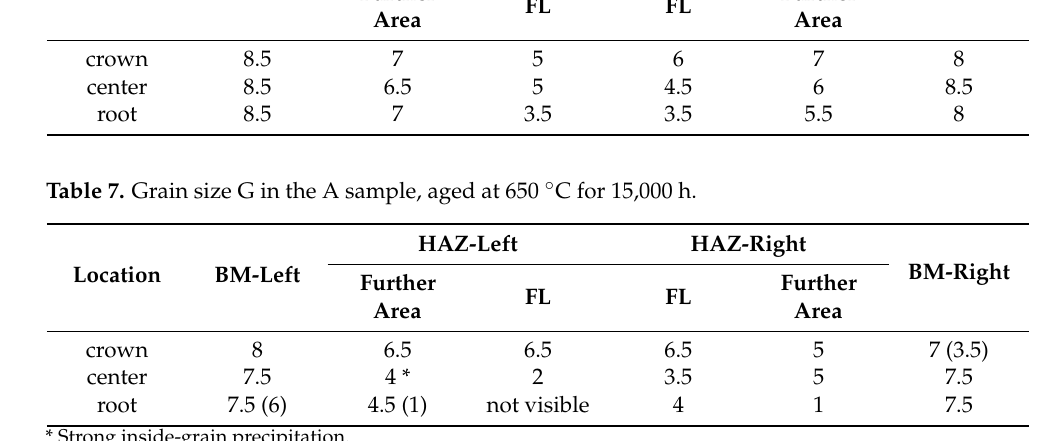
Location BM-Left